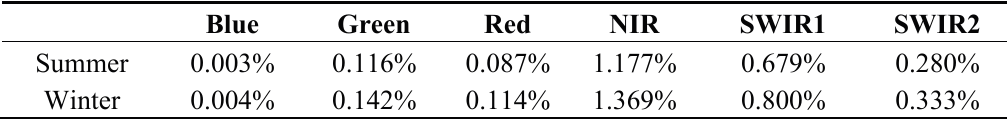
Table 3. Atmospheric uncertainty for same day coincident cross calibration over Libya